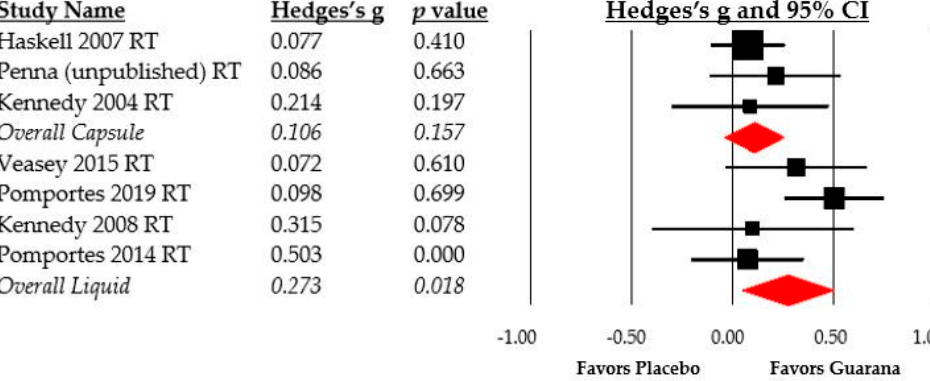
Figure 4. Forest plot of effect sizes for subgroup meta-analysis comparing guarana ingested either in the form of a capsule (top) or dissolved in liquid (bottom). The red diamond represents the effect size and the CI for each group. [16 − 19,21,22,34,35]